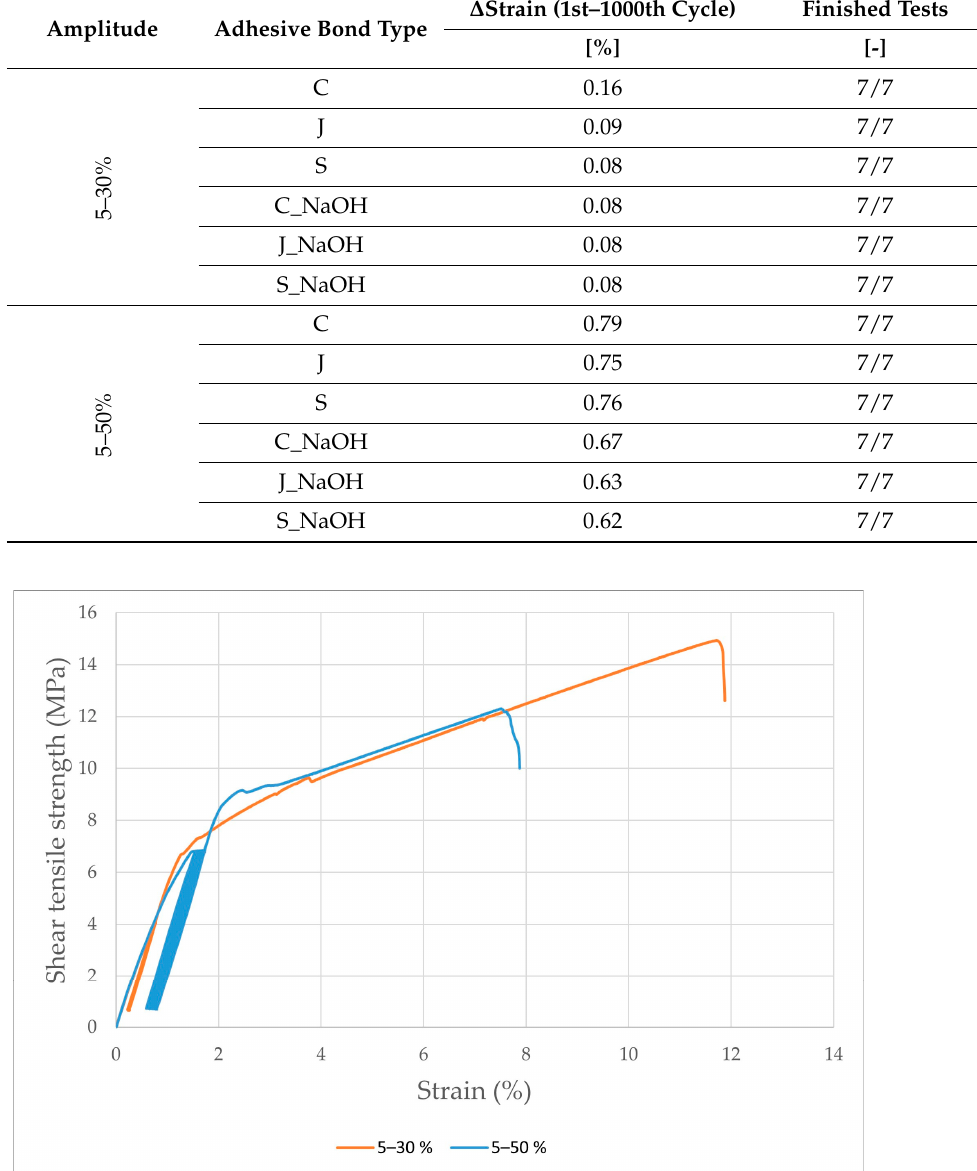
Table 5. Evaluation of cyclic loading tests of adhesive bonds with a composite adhesive layer.